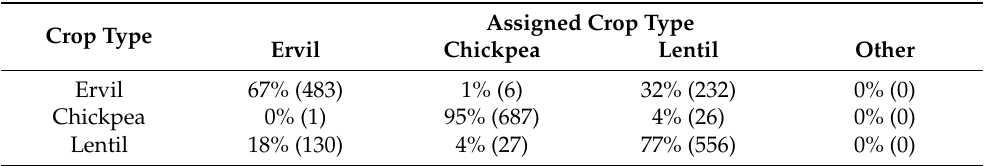
Table 7. Confusion matrix of the three studied zones for the three rVSI AM using the threshold values and RT as classification